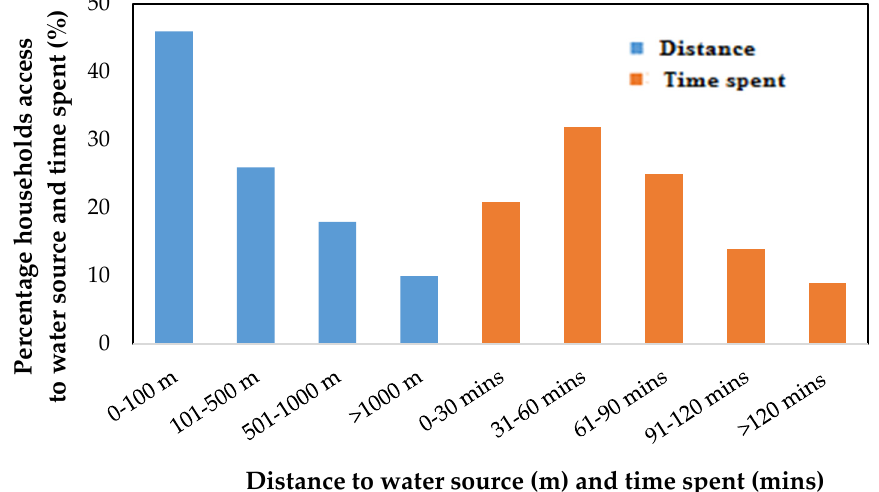
Distance to water source (m) and time spent (mins) Figure 4. Percentages of households’ distance and time spent to access their daily water use. From the figure, only 21%, which is less than a third of the surveyed households, spend 30 min or less to access their water supply. The remaining 79% of households fall beyond the UN’s recommended baseline time, which should not exceed 30 min to fetch water and return home [34]. The analysis revealed that productive time is lost to trekking and queuing for long hours to collect daily water